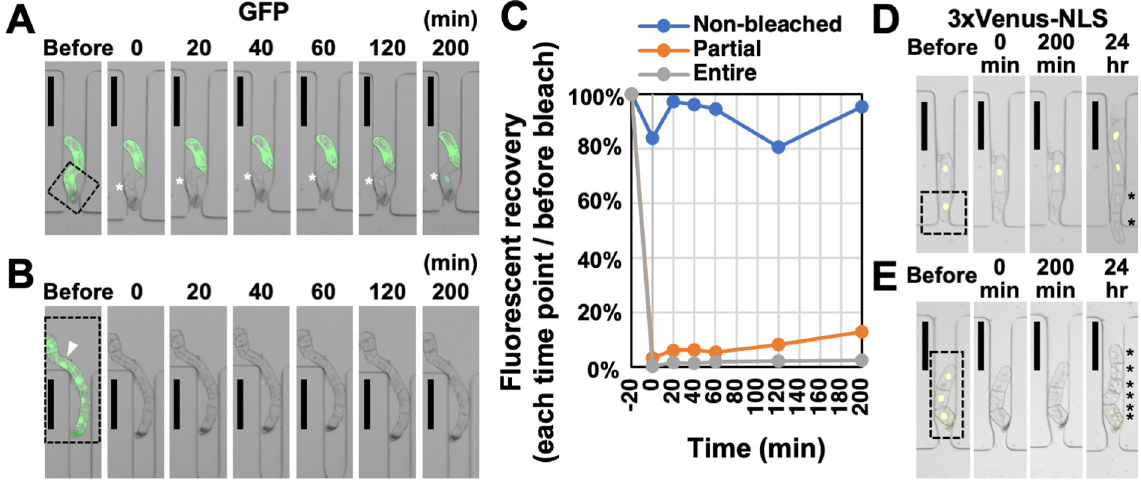
Fig 5. Evaluation of plasmodesmata permeability by FRAP. (A,B) Representative images of fluorescence recovery after photobleaching (FRAP) of BY-2 cells expressing green fluorescent protein (GFP) with cycloheximide. (A) Fluorescence recovery of filament, which only bleached a part. (B) Fluorescence recovery of filament that bleached the whole. Arrowhead indicates the cell analyzed in (C). (C) Measurement of fluorescence intensity by FRAP. The percentage of fluorescence intensity in each time point per that of before photobleaching was plotted. Blue (Non-bleached), the non-bleached cell in (A); orange (Partial), the bleached cell in (A); gray (Entire), the bleached cell in (B). (D,E) Representative images of FRAP of BY-2 cells expressing 3xVenus-NLS without cycloheximide. (D) Fluorescence recovery of filament, which only bleached a part. (E) Fluorescence recovery of filament that bleached the whole. Dashed rectangles indicate laser-irradiated areas. LSM images were merged from 8 consecutive optical sections. Fluorescence images were merged with bright-field images. Asterisks represent the recovery of fluorescence. Scale bars, 100 μ